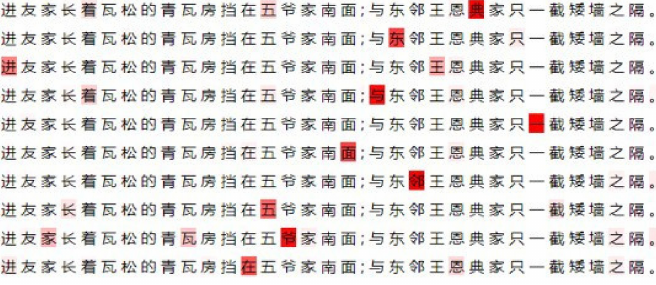
Figure 11. Instance of attention matrix visualization 2.